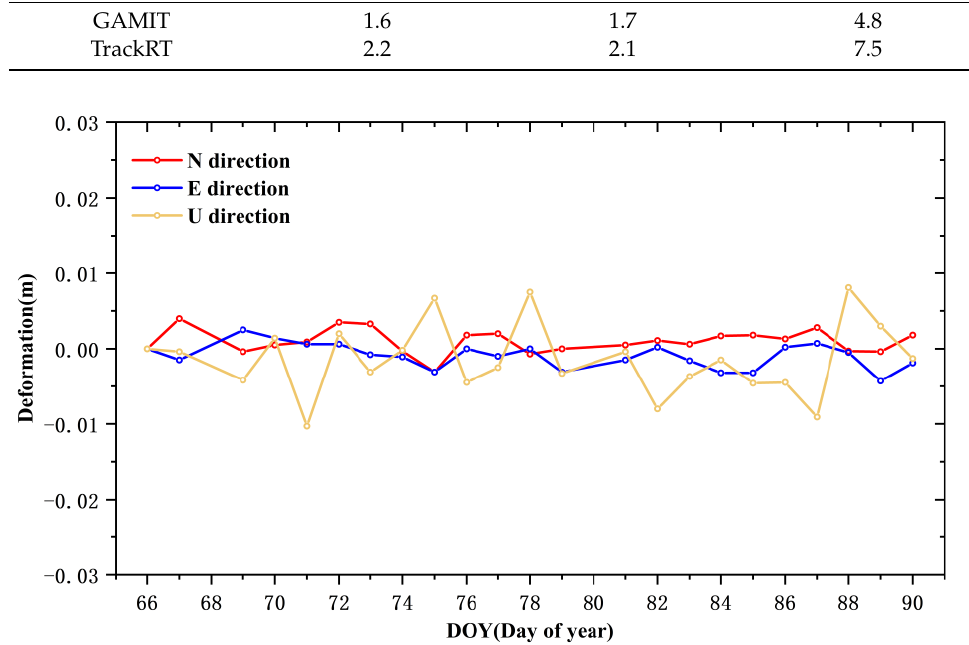
Figure 8. GAMIT baseline solving cumulative deformation.